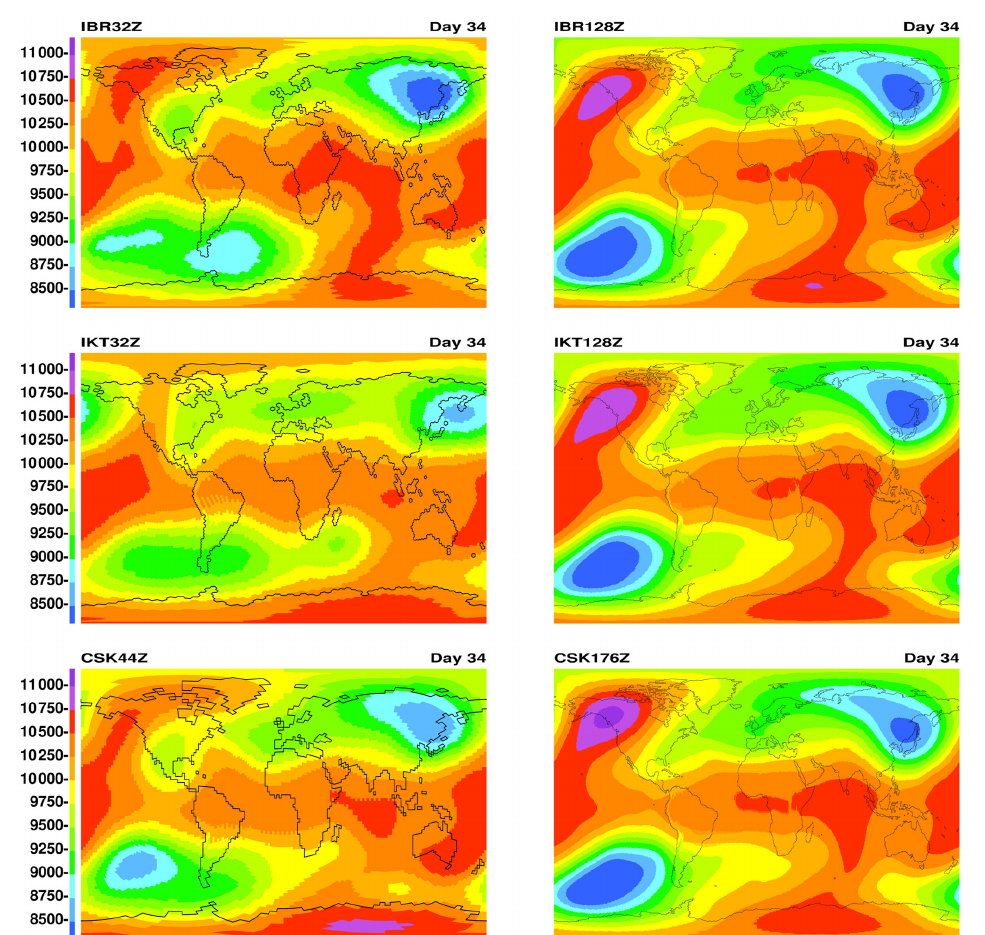
Figure 7. Horizontal plots of h + h S for models IBR, IKT, and CSK and resolutions 2 and 0 . 5 ◦ after 34 days of integration starting from 50ms − 1 eastward velocity multiplied by cosine of latitude, global mean height field top of 10000m but latitudinal distribution, and Earth’s fixed bottom topography (Test Case 3